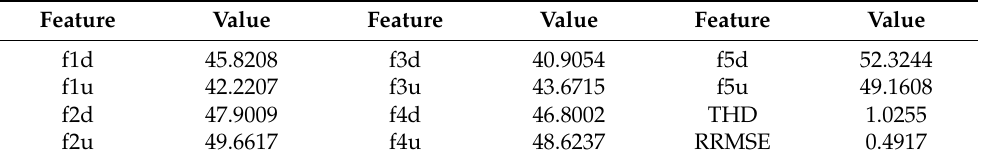
Table 9. Extracted features for milling machine